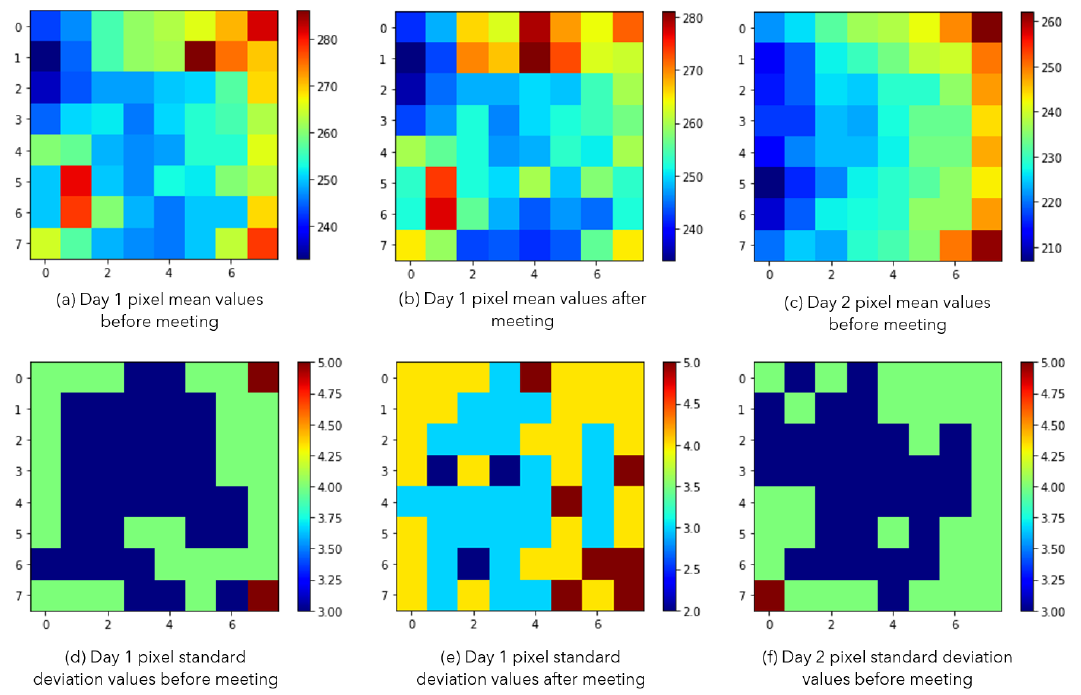
Figure 4. ( a , b ) show the pixel mean values ( m ( x , y ) ) for the empty room recording in Day 1 data ( h 1 ( x , y ) and h 2 ( x , y ) ) before and after meeting, ( c ) shows the pixel mean values for the empty room recording in Day 2 data ( h 10 ( x , y ) ) before the meeting, ( d , e ) show the pixel standard deviation values ( s ( x , y ) ) for Day 1 data ( h 1 ( x , y ) and h 2 ( x , y ) ) before and after meeting, ( f ) shows the pixel standard deviation values for ( h 10 ( x , y )